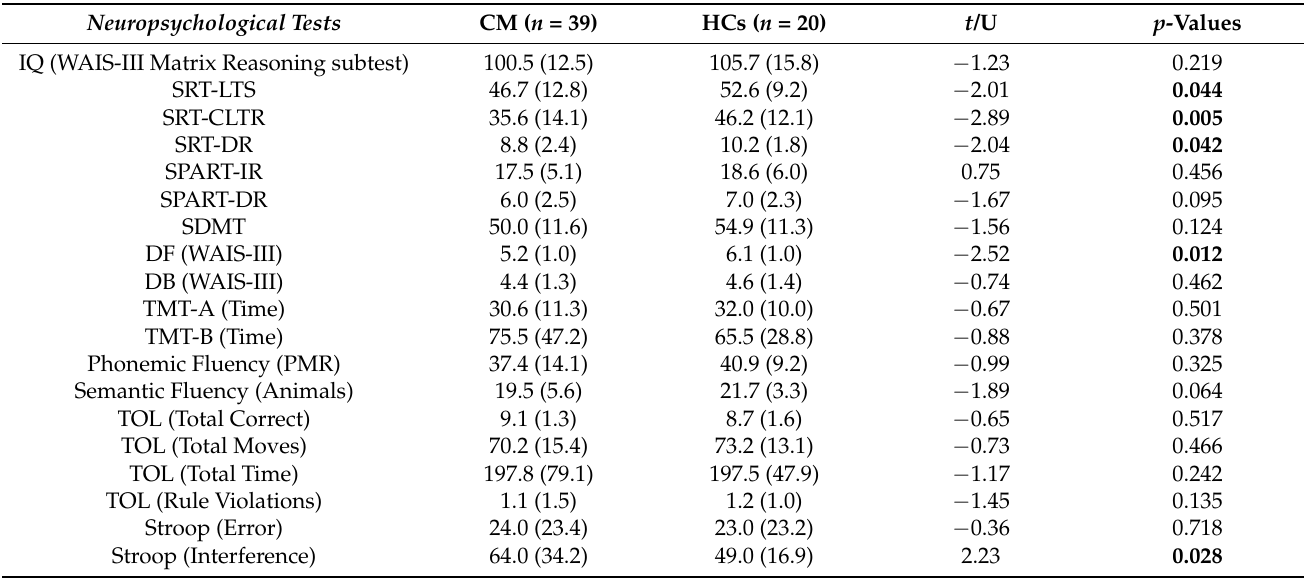
Table 2. Neuropsychological data of CM patients and HCs.